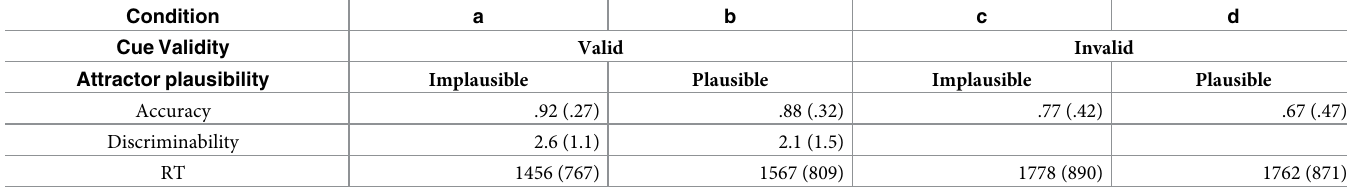
The mean accuracy and reaction time for each condition are summarised in Table 3. I com- pared 2AFC judgments of the interpretations when the attractor was plausible to when the attractor was implausible (see Fig 2). The former was calculated by subtracting a standardized percentage of ungrammatical interpretation responses in (c) from the standardized percentage of grammatical interpretation responses in (a), and the latter by subtracting the standardized percentage of incorrect responses in (d) from the standardized percentage of correct responses in (b). Paired t -tests revealed that the discriminability between grammatical and ungrammati- cal interpretations of the ellipsis in the presence of an Implausible Attractor ( M = 2.6, SD = 1.1) was significantly higher than that in the presence of a Plausible Attractor ( M = 2.1, SD = 1.5), t (155) = 3.3, p < .001 in the item analysis, but was not significant in the participant analy- sis, p < .1. A further linear mixed effects model was constructed with the lme4 package [59] in